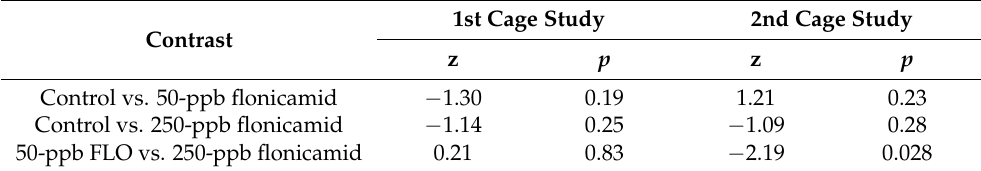
Table 3. Post hoc t test statistics and probability ( p ) values for consumption per bee per day for the two laboratory cage studies. 1st Cage Study 2nd Cage Study Contrast t p t p Control vs. 50-ppb flonicamid − 0.73 1.00 − 0.03 1.00 Control vs. 250-ppb flonicamid − 1.62 0.36 0.20 1.00 50-ppb FLO vs. 250-ppb flonicamid − 0.89 1.00 0.23 1.00 Table 4. Z scores and probability ( p ) values for the Cox regression survivorship analysis for two laboratory cage studies. 1st Cage Study 2nd Cage Study Contrast z p z p Control vs. 50-ppb flonicamid − 1.30 0.19 1.21 0.23 Control vs. 250-ppb flonicamid − 1.14 0.25 − 1.09 0.28 50-ppb FLO vs. 250-ppb flonicamid 0.21 0.83 − 2.19